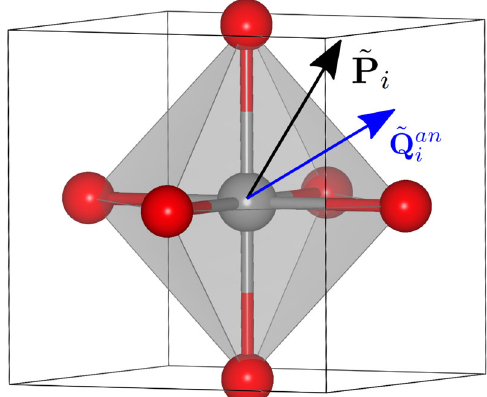
Fig. 14 Sketch of the i -th Ti-center of structure A, along with its enclosing oxygen cage and the two vectors ~ P i ð A Þ and ~ Q associated with it. The fi nal CV is computed as a scalar product of these quantities after fi rst summing over all